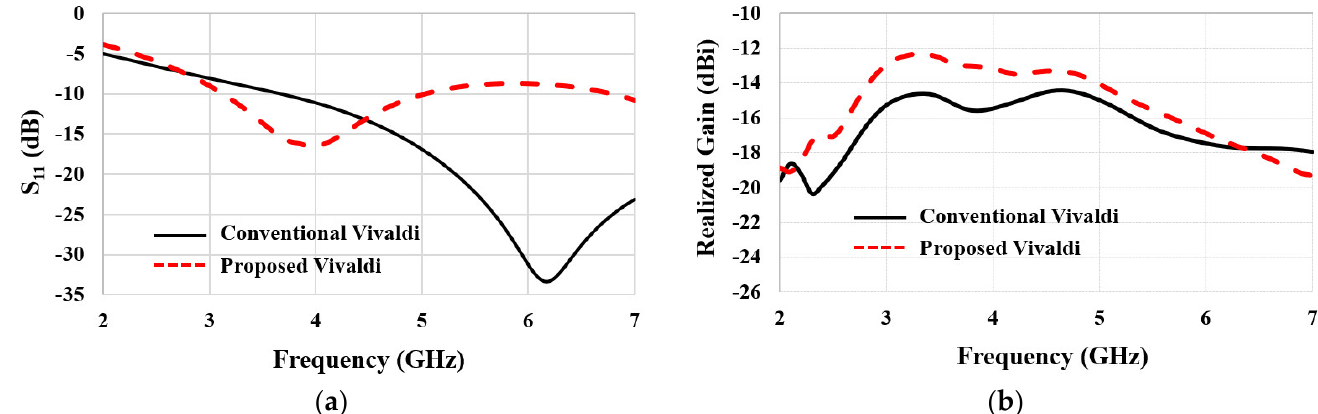
Figure 5. Comparisons of ( a ) S 11 and ( b ) realized gain of conventional and proposed Vivaldi antennas.